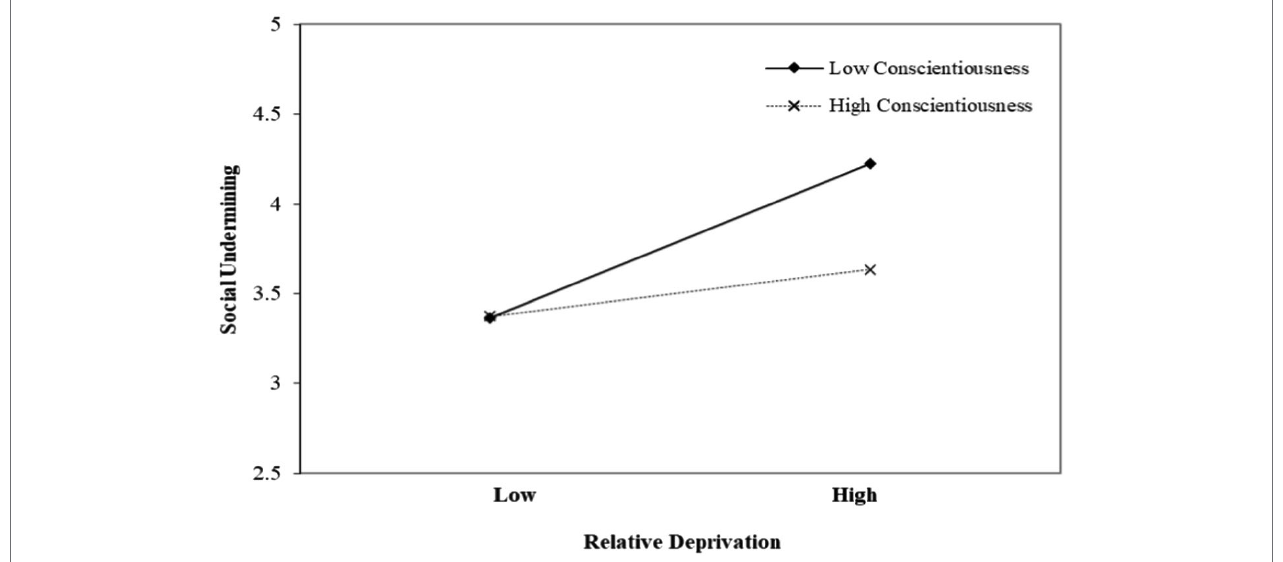
FIGURE 3 | The moderating effect of conscientiousness on the relationship between relative deprivation and social undermining.